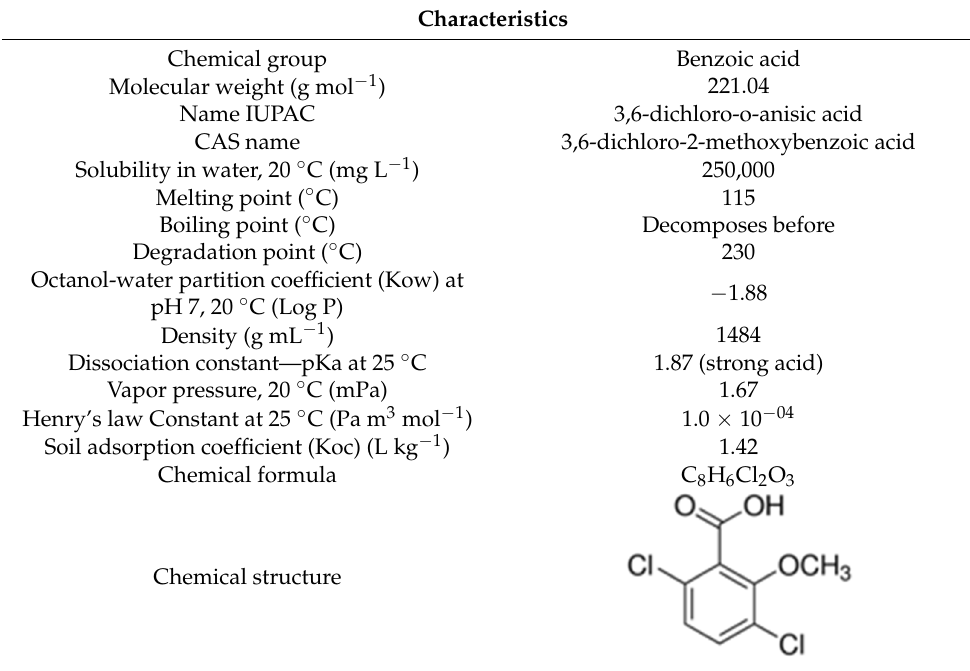
Table 1. Physicochemical characteristics of dicamba (not including its salts).